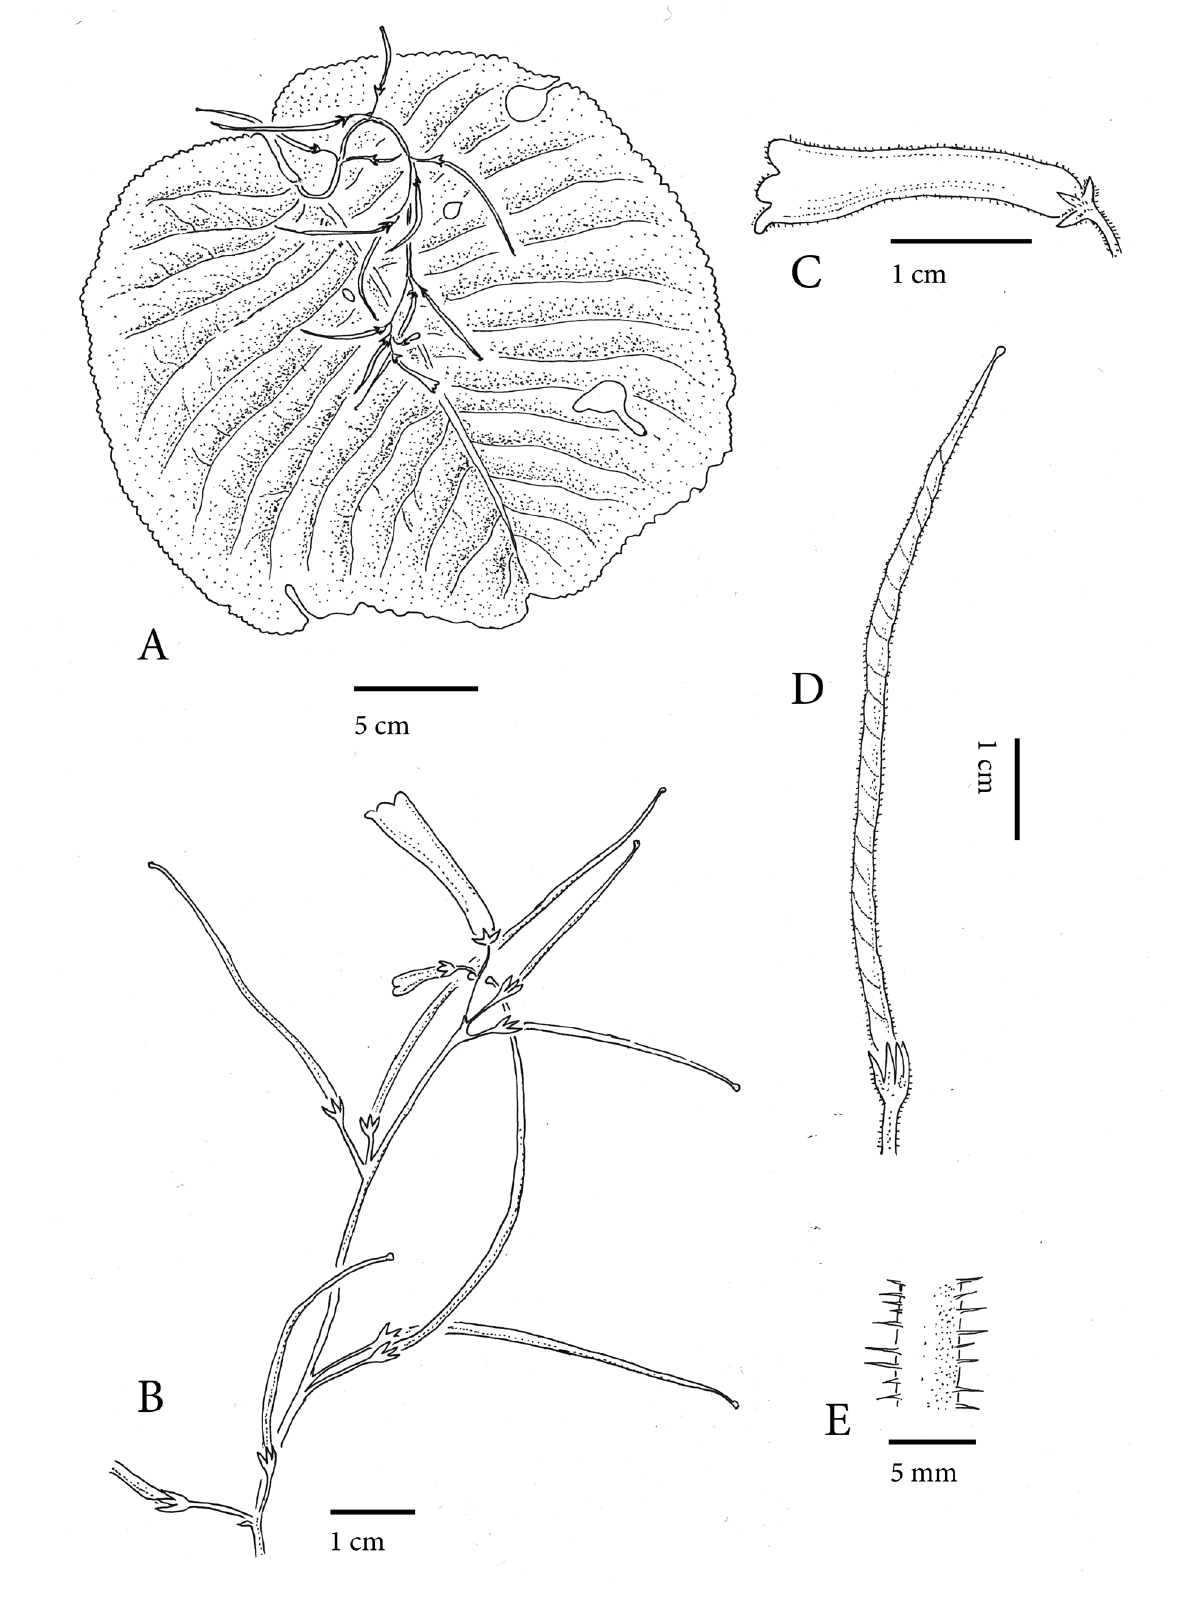
Figure 6 – Streptocarpus salesianorum. A . Habit. B . Inflorescence. C . Corolla. D . Mature capsule. E . Hairs on the ovary. From E.Hofmann S 1799 . Illustration by Eberhard